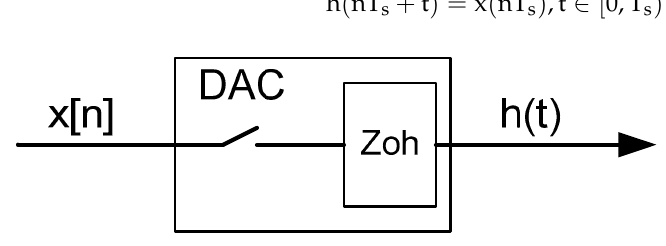
Figure 15. Reference figure for Zoh analysis.